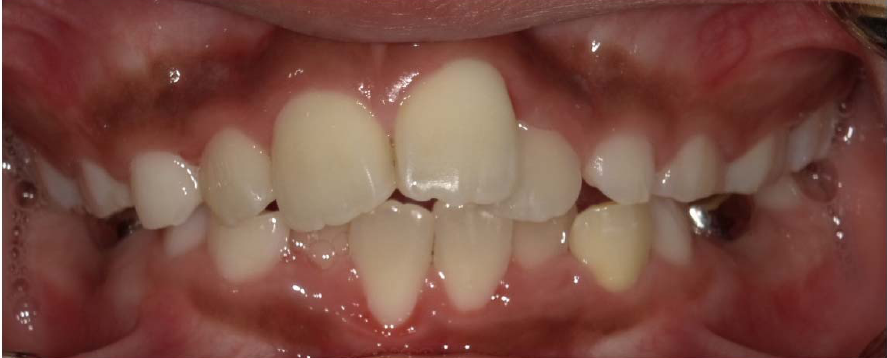
Figure 6. Crowding in the anterior region of a male X ‐ linked hypophosphatemia (XLH) patient aged 10 years 1 month.